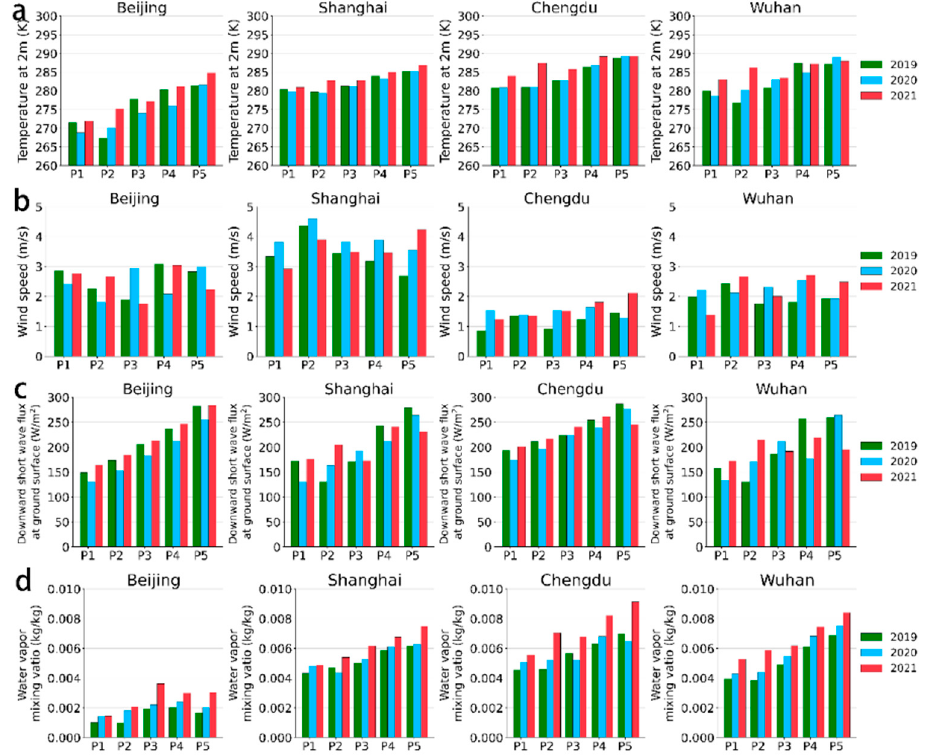
Figure 9. Comparison of meteorological factor stage averages for selected cities 2019–2021. ( a ) Temperature at 2 m, ( b ) wind speed, ( c ) downward short wave flux at ground surface, ( d ) water vapor mixing.